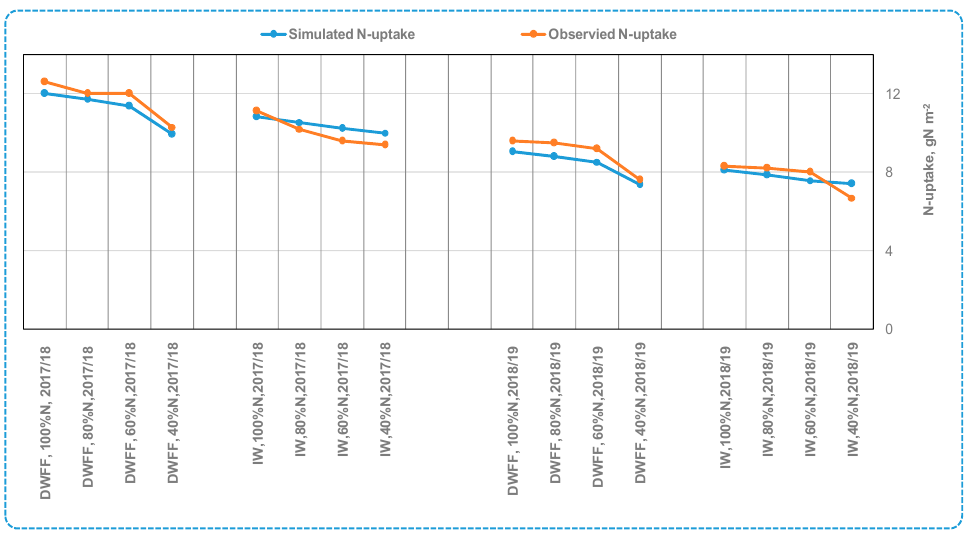
Figure 11. Effect of water quality and nitrogen fertigation on N uptake during growing seasons and compared with simulated nitrogen uptake for the 2017/2018 and 2018/2019 seasons for all treatments: drainage water from fish farms(DWFF), fresh irrigation water (IW) and nitrogen (N).